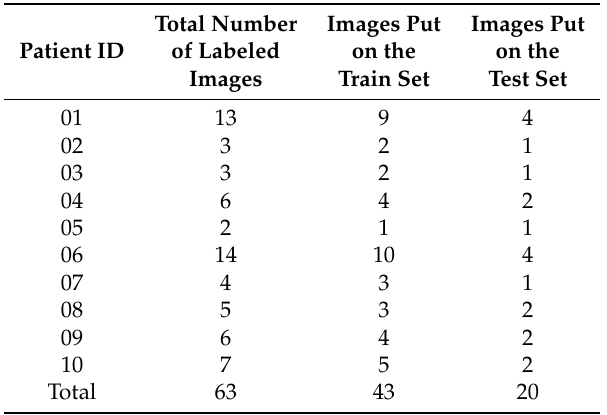
Table 1. Composition of